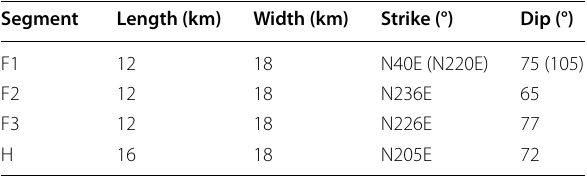
Table 1 Initial model parameters of fault planes assumed in the waveform